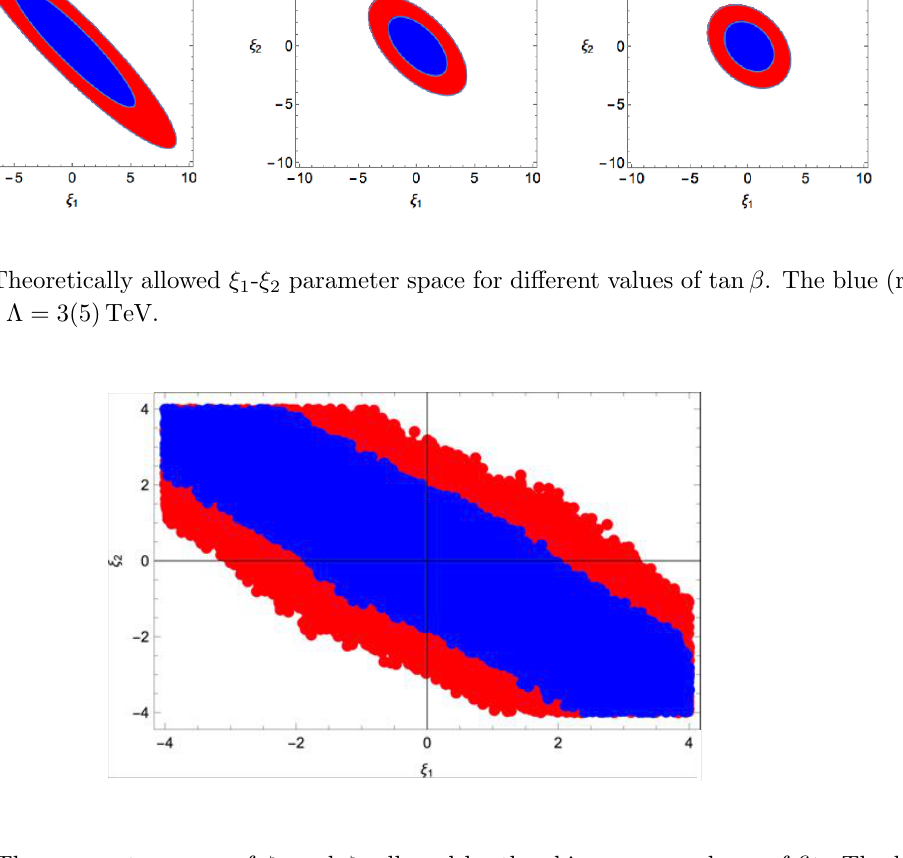
; K parameters and the H h